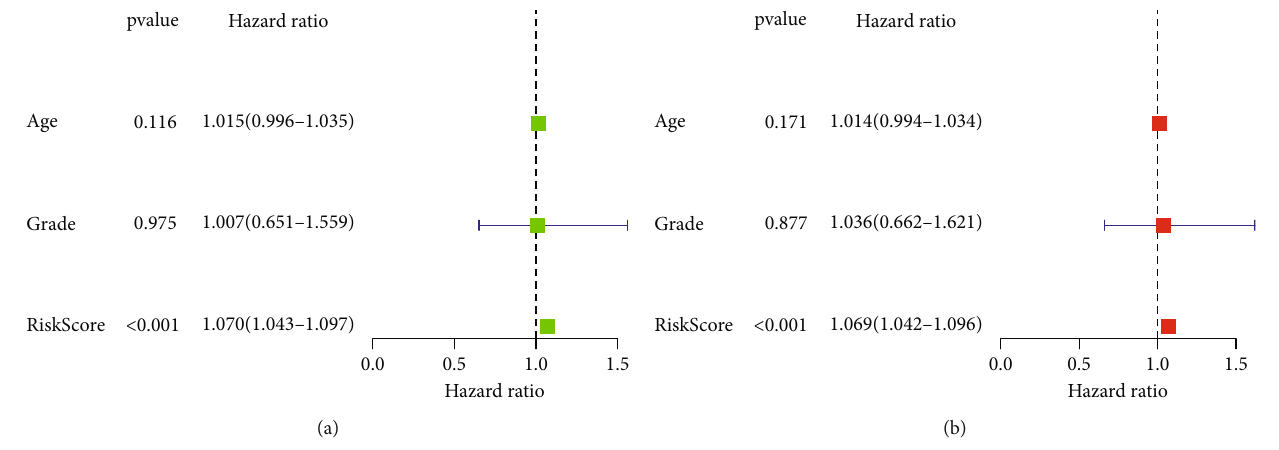
Figure 4: Univariate and multivariate assays of prognostic factors in CC